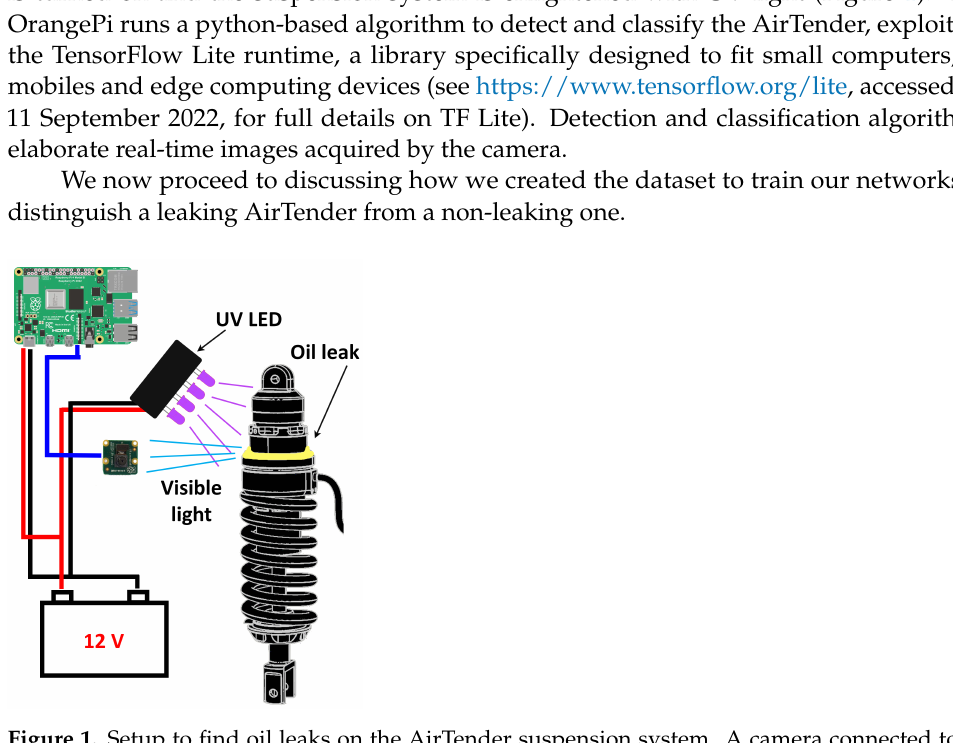
Figure 1. Setup to find oil leaks on the AirTender suspension system. A camera connected to an on-board device records the core of AirTender, while UV LEDs make oil fluoresce. The LEDs and the on-board device are powered by the on-board battery. The on-board device elaborates the images recorded by the camera through the neural networks trained for this